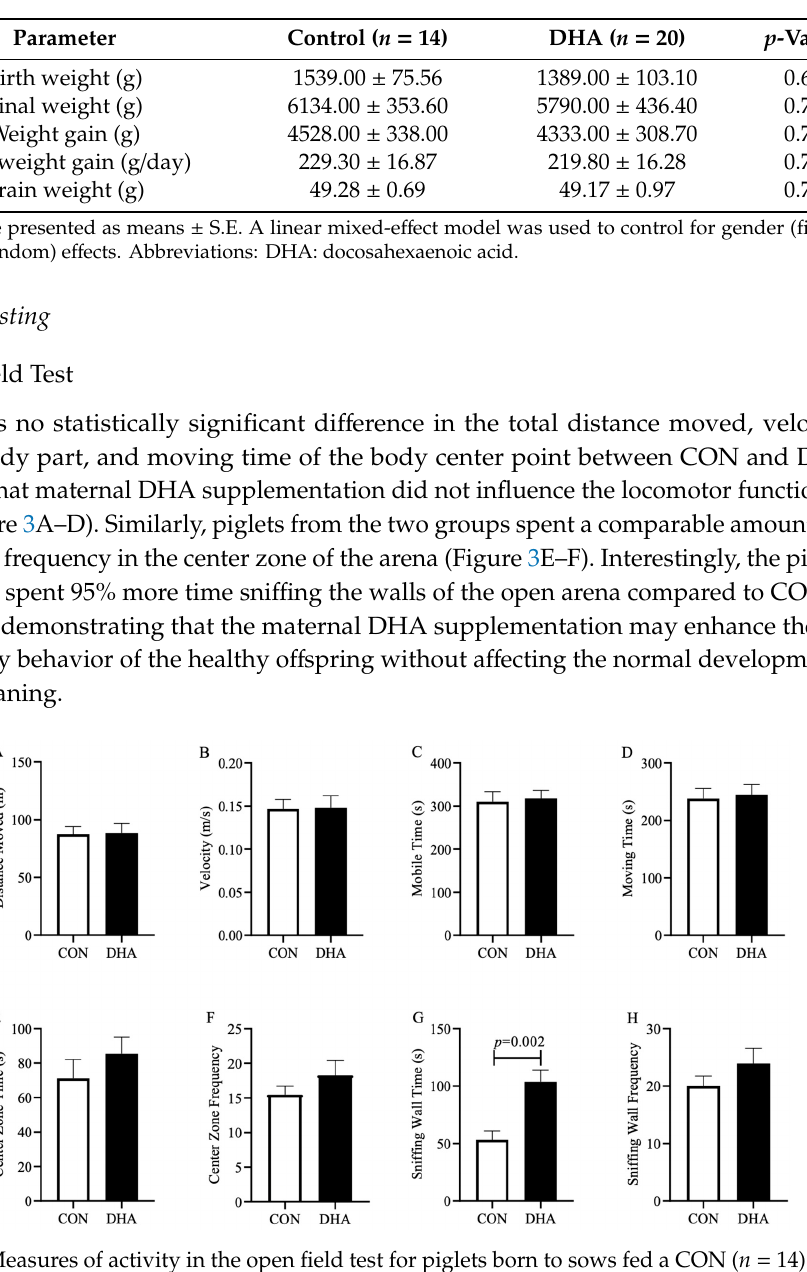
Table 3. Body weight and brain weight of piglets at weaning.